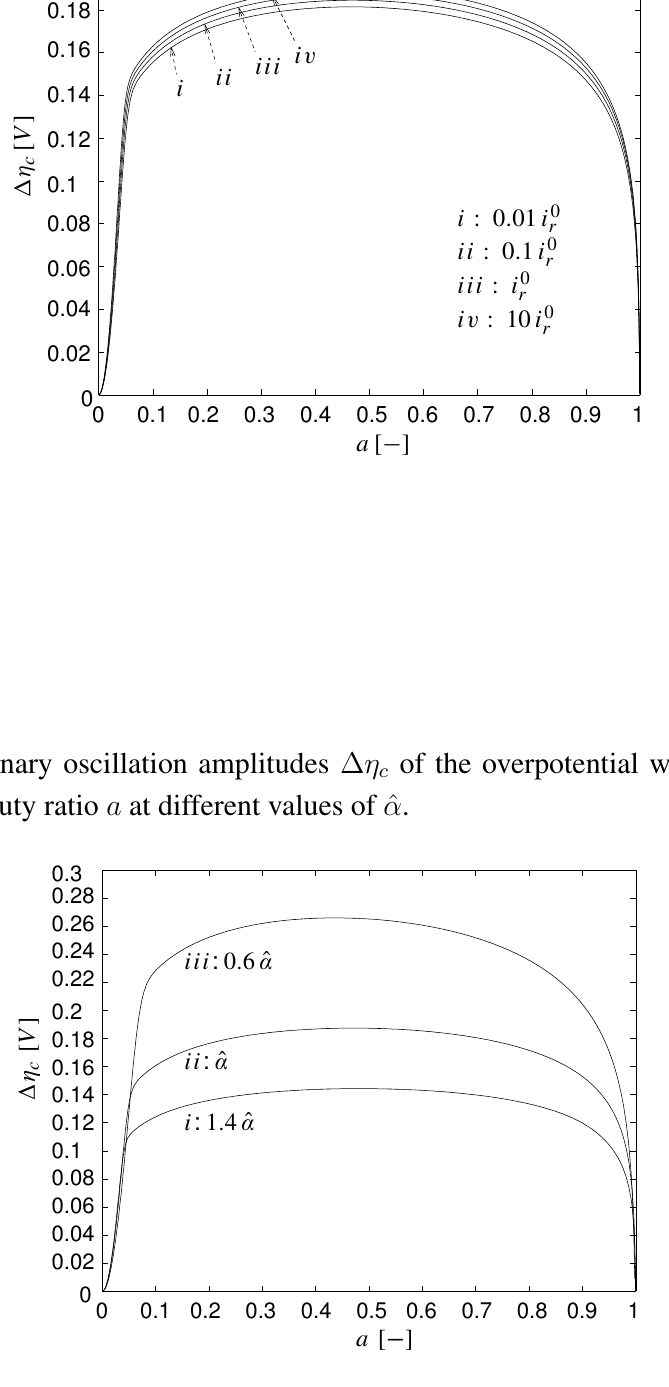
Figure 14. Stationary oscillation amplitudes ∆ η buck converter’s duty ratio a at different exchange current densities i 0